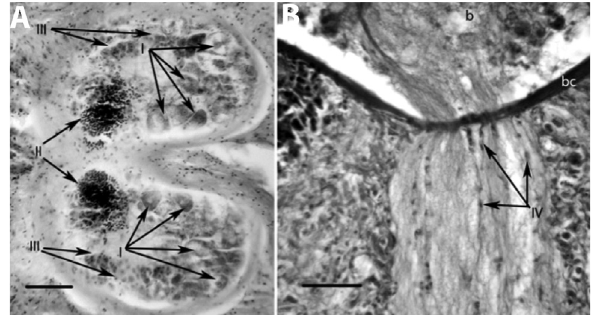
Figure 4 - Polyclad brain cell types. Longitudinal sections of the brain and nervous branches show distinguishable brain cells in Styloplanocera fasciata . A. Type I large ganglion cells with big nuclei; Type II globuli cells; Type III medium-sized cells. Scale bar 75 (cid:2) m. B. Type IV small cells of elongated shape located along the nerve tracts. Scale bar 25 (cid:2) m. b brain, bc brain